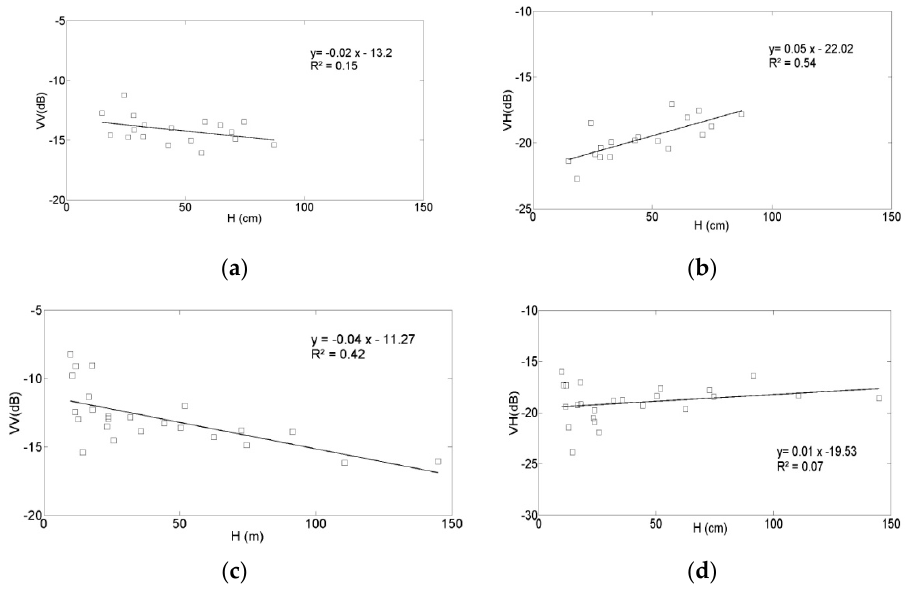
Figure 9. Sentinel-1 (S1) radar data as a function of H in two soil moisture (mv) classes: ( a ) VV polarization, mv < 15 vol. %; ( b ) VH polarization, mv < 15 vol. %; ( c ) VV polarization, mv > 15 vol. %; ( d ) VH polarization, mv > 15 vol. %.